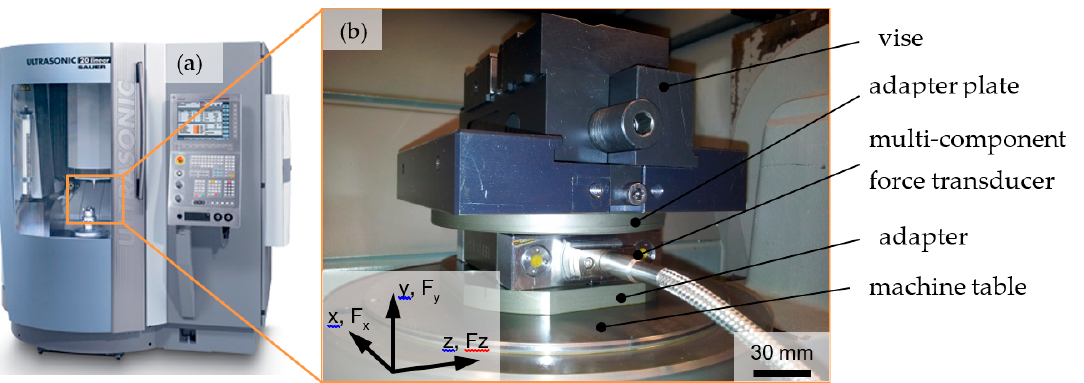
Figure 3. ( a ) DMG Sauer 20 linear machine tool and ( b ) setup for force measurement system.